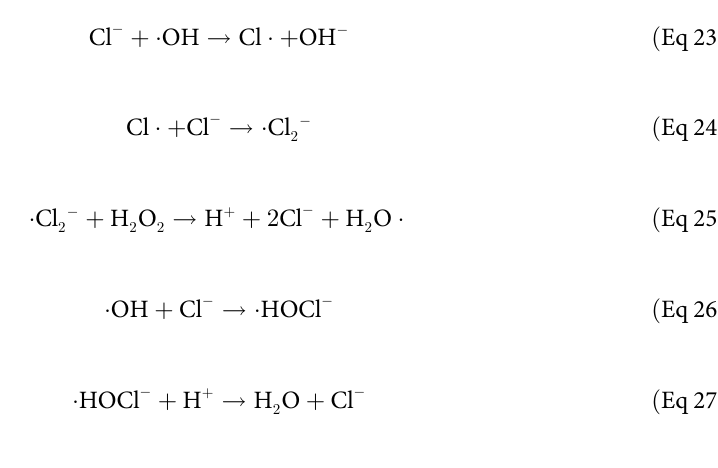
Fig 6. Effect of CO 32- on the removal rate (a), kinetics constant (b) and linear fitting between kinetics constant and concentration of CO 32- on the degradation of NIF via UV/H 2 O 2 . The error bars represent the standard deviation (n = 3). -36.25% (Cl - concentration = 5 mg/L) < -18.61% (Cl - concentration = 20 mg/L) < 24.71% (Cl - concentration = 50 mg/L), which was in keeping with the trend of kinetics constant: 1.09588 min -1 (Cl - concentration = 50 mg/L) < 1.72666 min -1 (Cl - concentration = 20 mg/L) < 1.98350 min -1 (Cl - concentration = 5 mg/L). The reaction mechanism between Cl - and � OH is shown in (Eq 23) to (Eq 27) [39]: